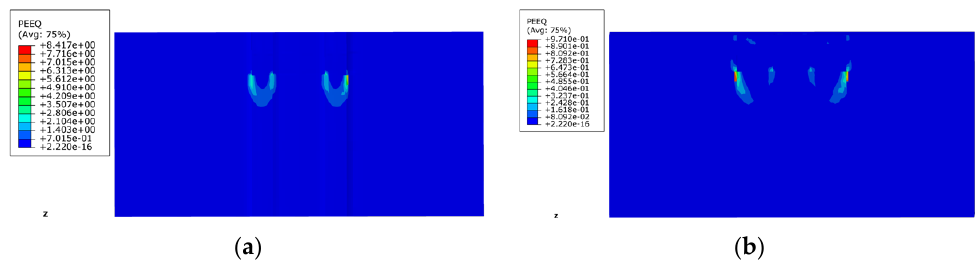
Figure 3. Vertical load – displacement curve of the TSPJF and TBJF at the loading points.